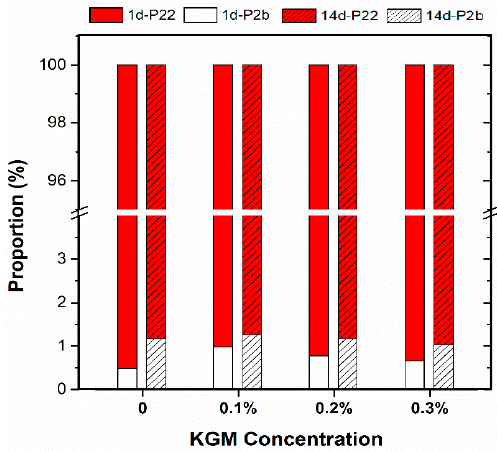
Figure 6. The proportion of water distribution of amylose–KGM mixtures at different storage times. (1d-P22 and 1d-P2b represent the proportions of free water and bound water in the mixtures after 1 day of storage, respectively; 14d-P22 and 14d-P2b represent the proportions of free water and bound water after 14 days of storage, respectively).